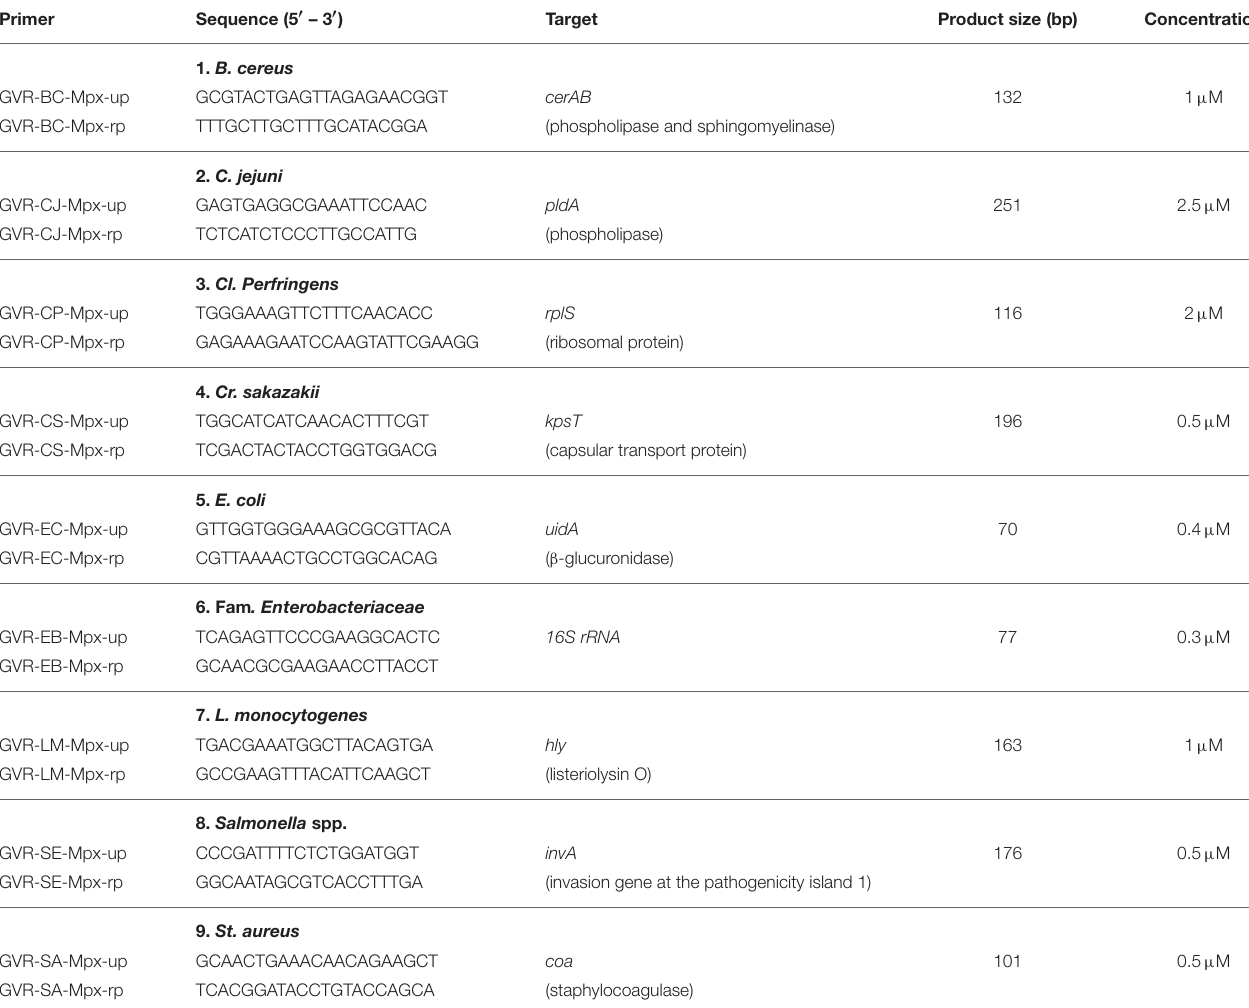
TABLE 3 | List of oligonucleotides designed for mPCR and final oligonucleotides concentrations in the mPCR. Primer Sequence (5 ′ – 3 ′ ) Target Product size